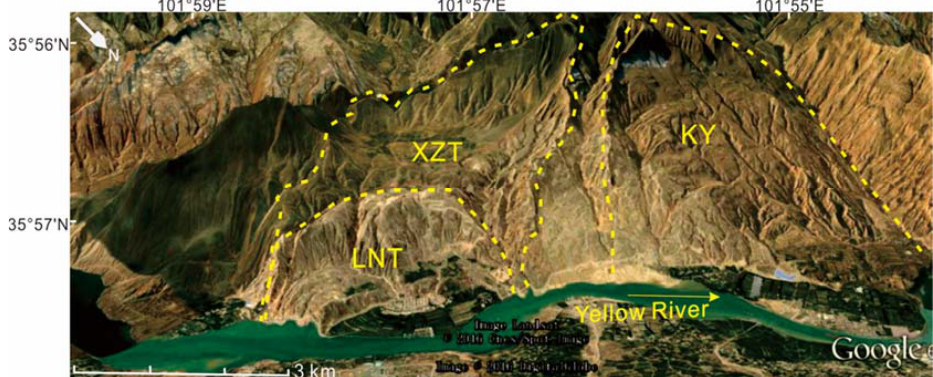
Figure 4. Google images for Xiazangtan, Kangyang and Lannitan landslides, which are abbreviated as XZT, KY and LNT.